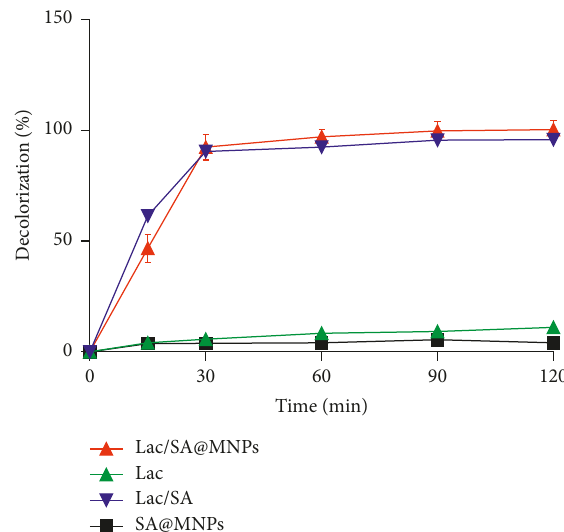
Figure 8: Dye decolorization by Lac/SA@MNPs, Lac/SA, SA@MNPs, and Lac alone as a function of time.